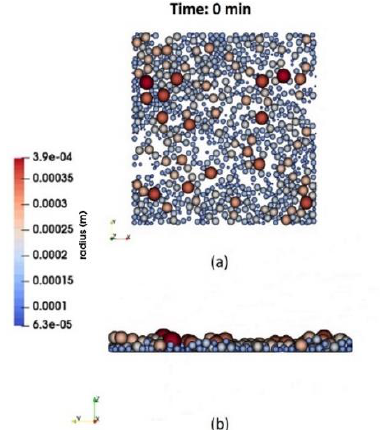
Fig. 4 Initial configuration, (a) top and (b) lateral views, of the system.